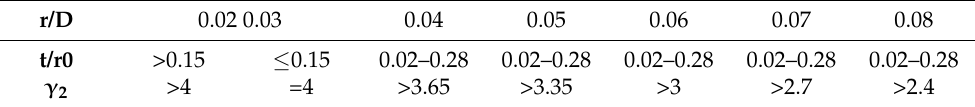
Table 8. Ranges of pressure coefficient at the fold stage for a/2 h = 0.9–1.1.